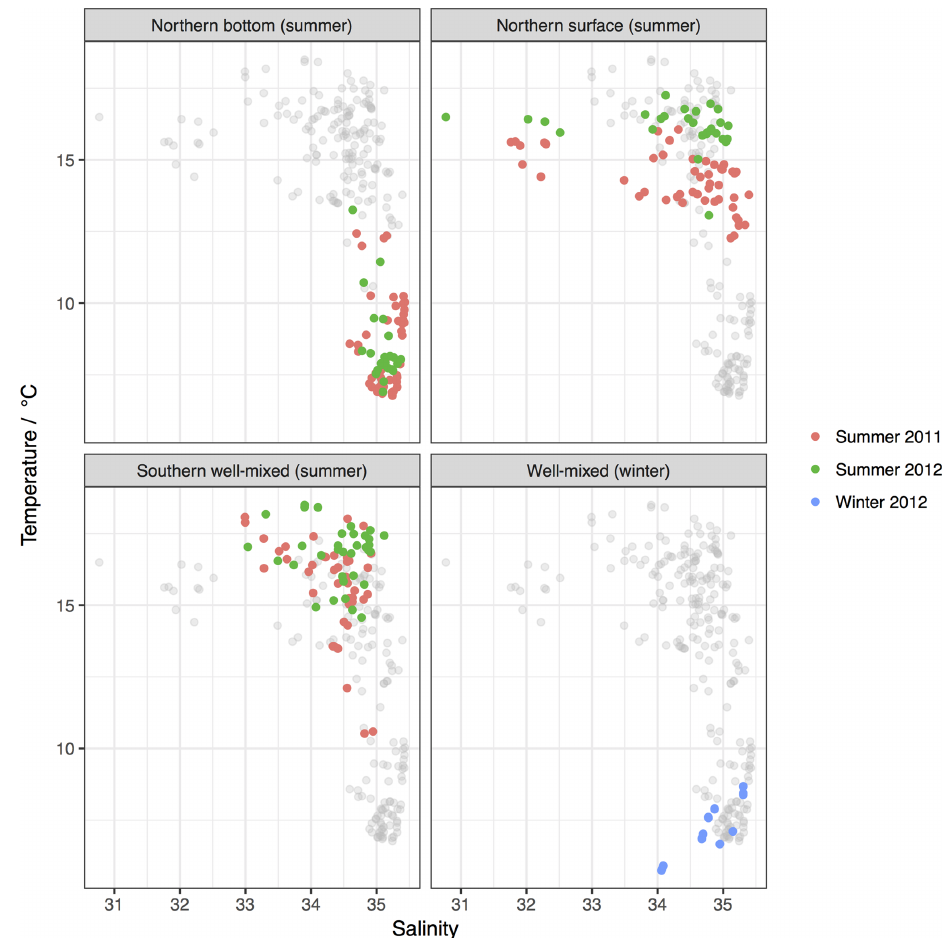
Figure 3. Temperature–salinity plots divided by location, season and cruise. Grey points show the whole dataset from all other water types or